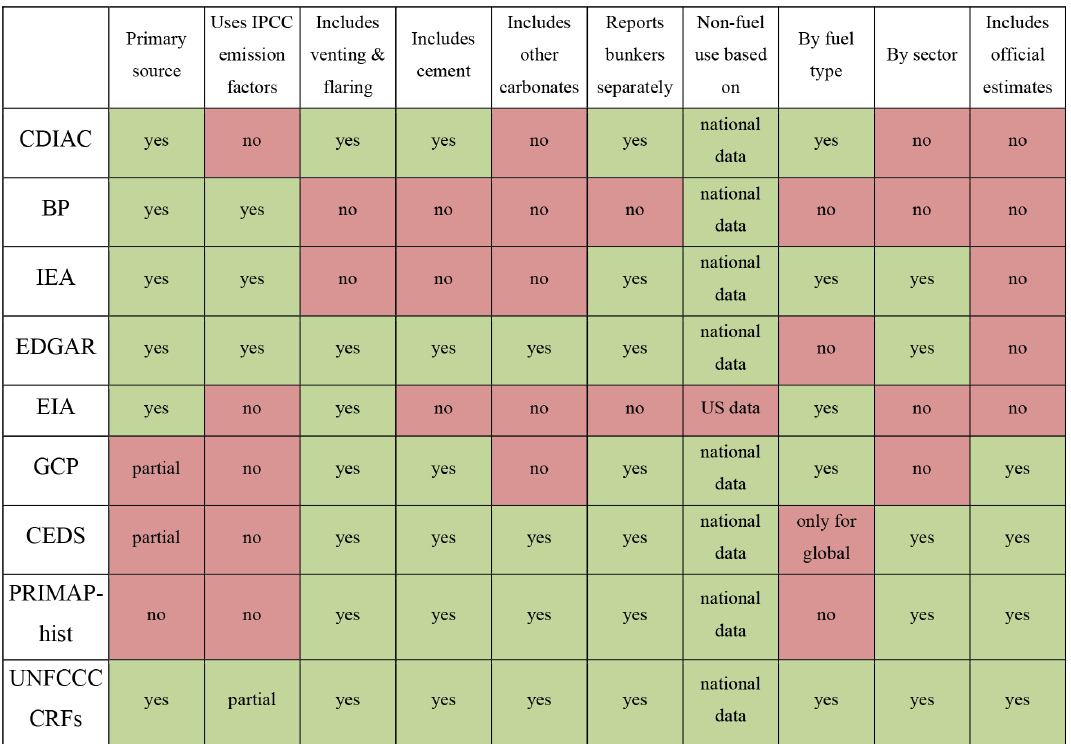
Table 2. Comparison of some important general characteristics of nine emissions datasets, with green indicating a characteristic that might be considered a strength. The partial use of IPCC default emissions factors by UNFCCC CRFs is considered a strength because when default factors are not used more accurate country-specific factors are